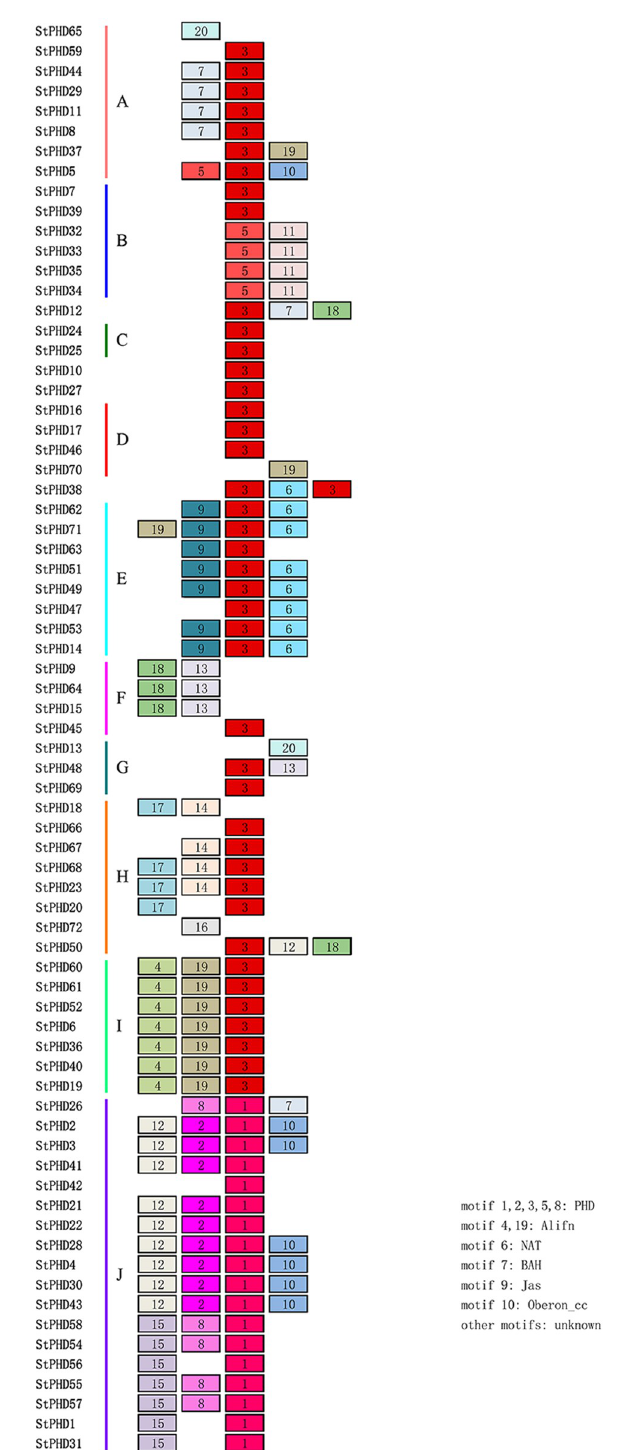
Fig 2. Schematic diagram of conserved motifs for StPHD proteins. Different motifs are displayed with different colored boxes and numbers (1–20). The annotation of each motif listed on the right, which was identified by CDD